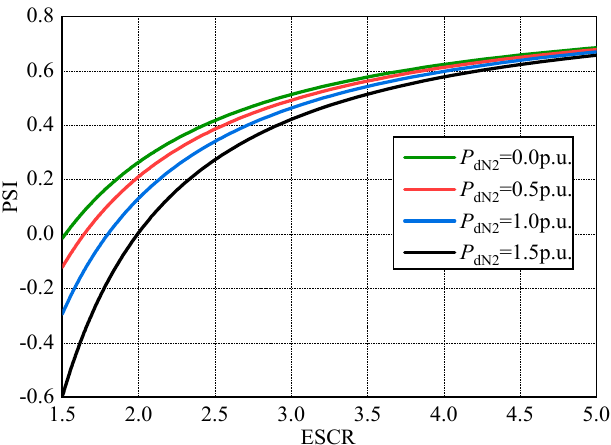
Figure 6. Curves of PSI versus ESCR for different P dN2 under VSC-HVDC constant reactive power control mode.